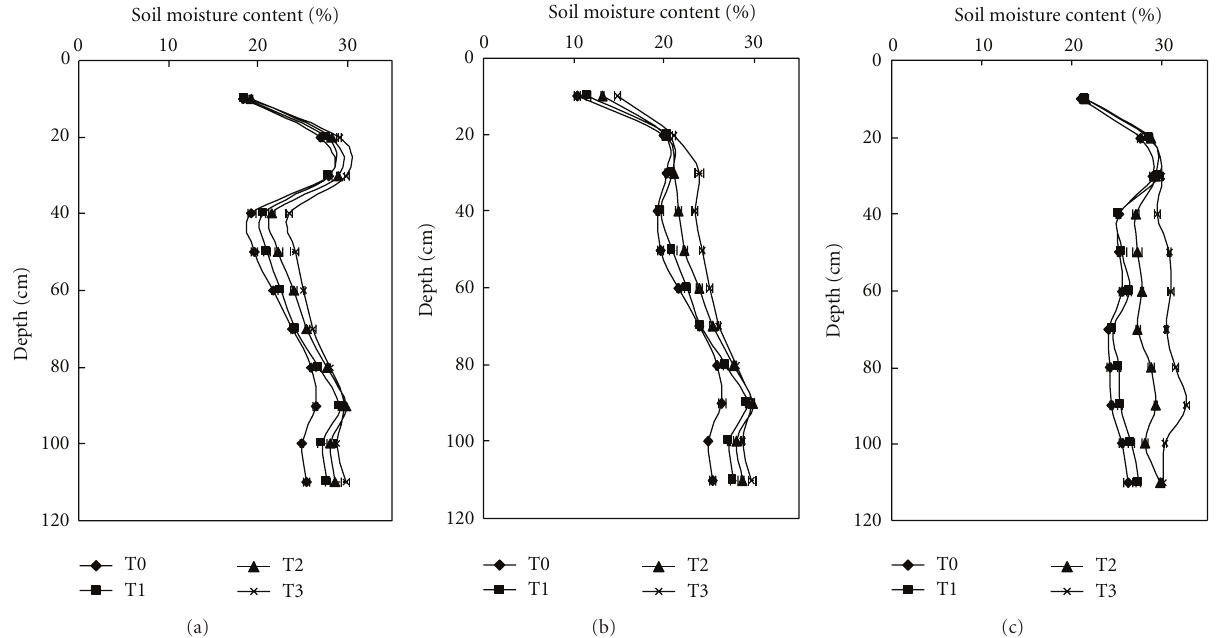
Figure 1: Soil moisture status before summer maize sowing in 2002 (a), 2003 (b), and 2005 (c). Horizontal bars are standard errors.